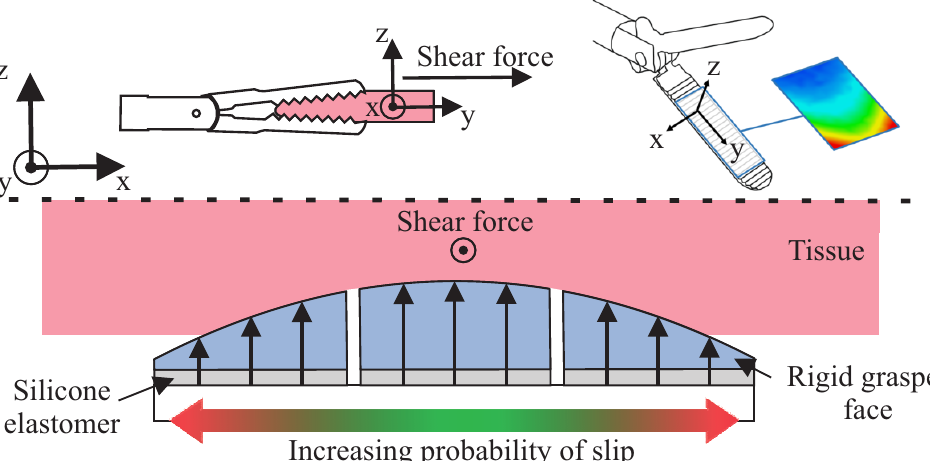
Figure 1. Diagram demonstrating the concept of encouraging incipient slips across the grasper face by varying the normal force using a curved